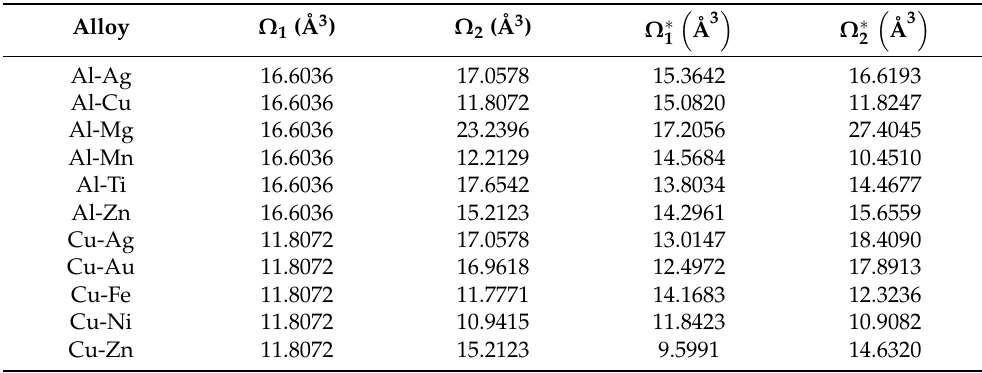
Table 3. The real (experimental) atomic volumes ( Ω 1 and Ω 2 ) and apparent atomic volumes ( Ω ∗ Ω ∗ ) for the selected binary 2